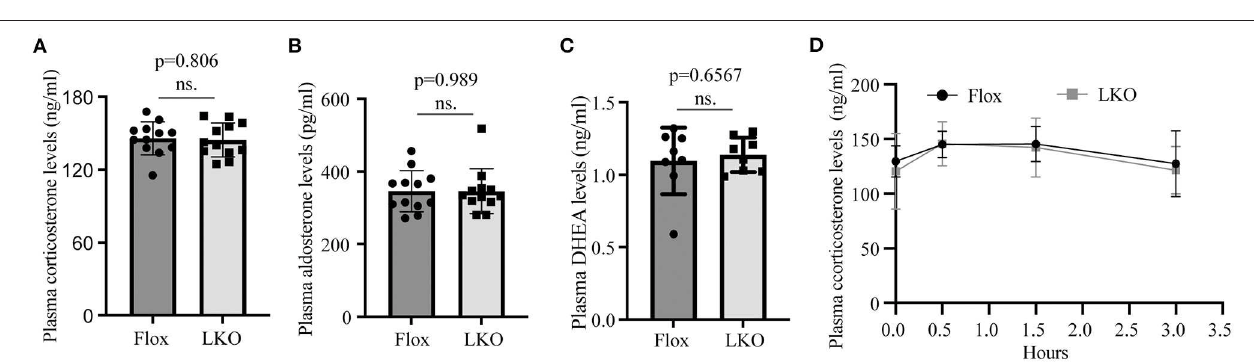
FIGURE 3 | Impact of lacking hepatic Surf4 on plasma levels of adrenal hormones. (A–C) Plasma adrenal hormone levels. Blood samples were collected from non-fasted mice [ Surf4 Flox (Flox) and Surf4 LKO (LKO) mice, 10–14-week-old]. Aldosterone (A) , corticosterone (B) , and DHEA (C) were measured using their specific ELISA kits. (D) qRT-PCR. Total RNAs were extracted from adrenal glands and then subjected to qRT-PCR. The relative mRNA levels were the ratio of the target’s mRNA levels indicated to that of Gapdh at the same condition ( n = 4). Values of all data were mean ± S.D. p > 0.05 was defined as no significant difference (ns.).